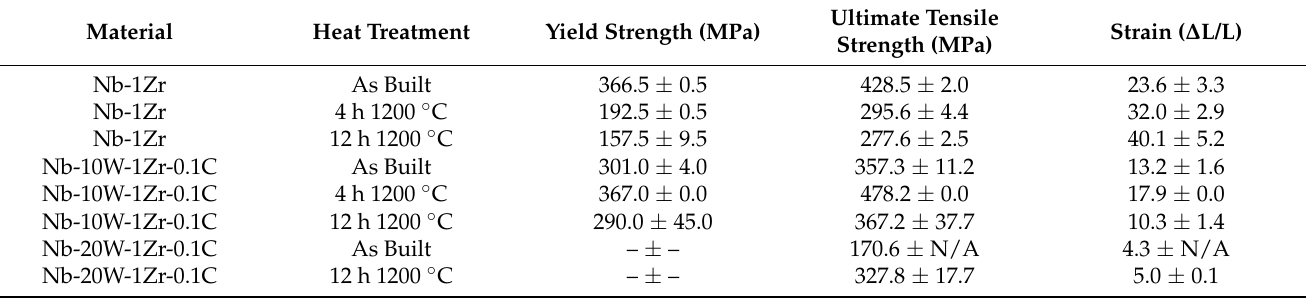
Table 4. Tensile properties of as fabricated and heat-treated Nb-1Zr, Nb-10W-1Zr-0.1C, and